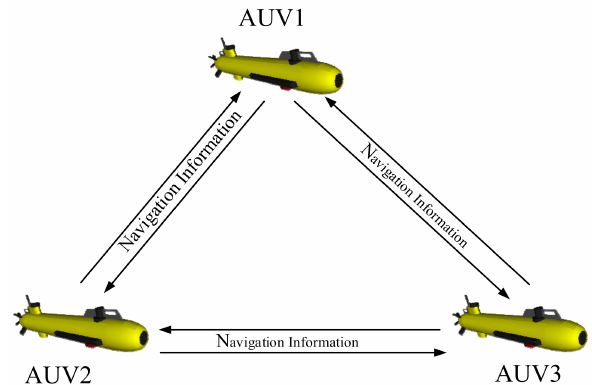
Figure 1. The network structure of multiple